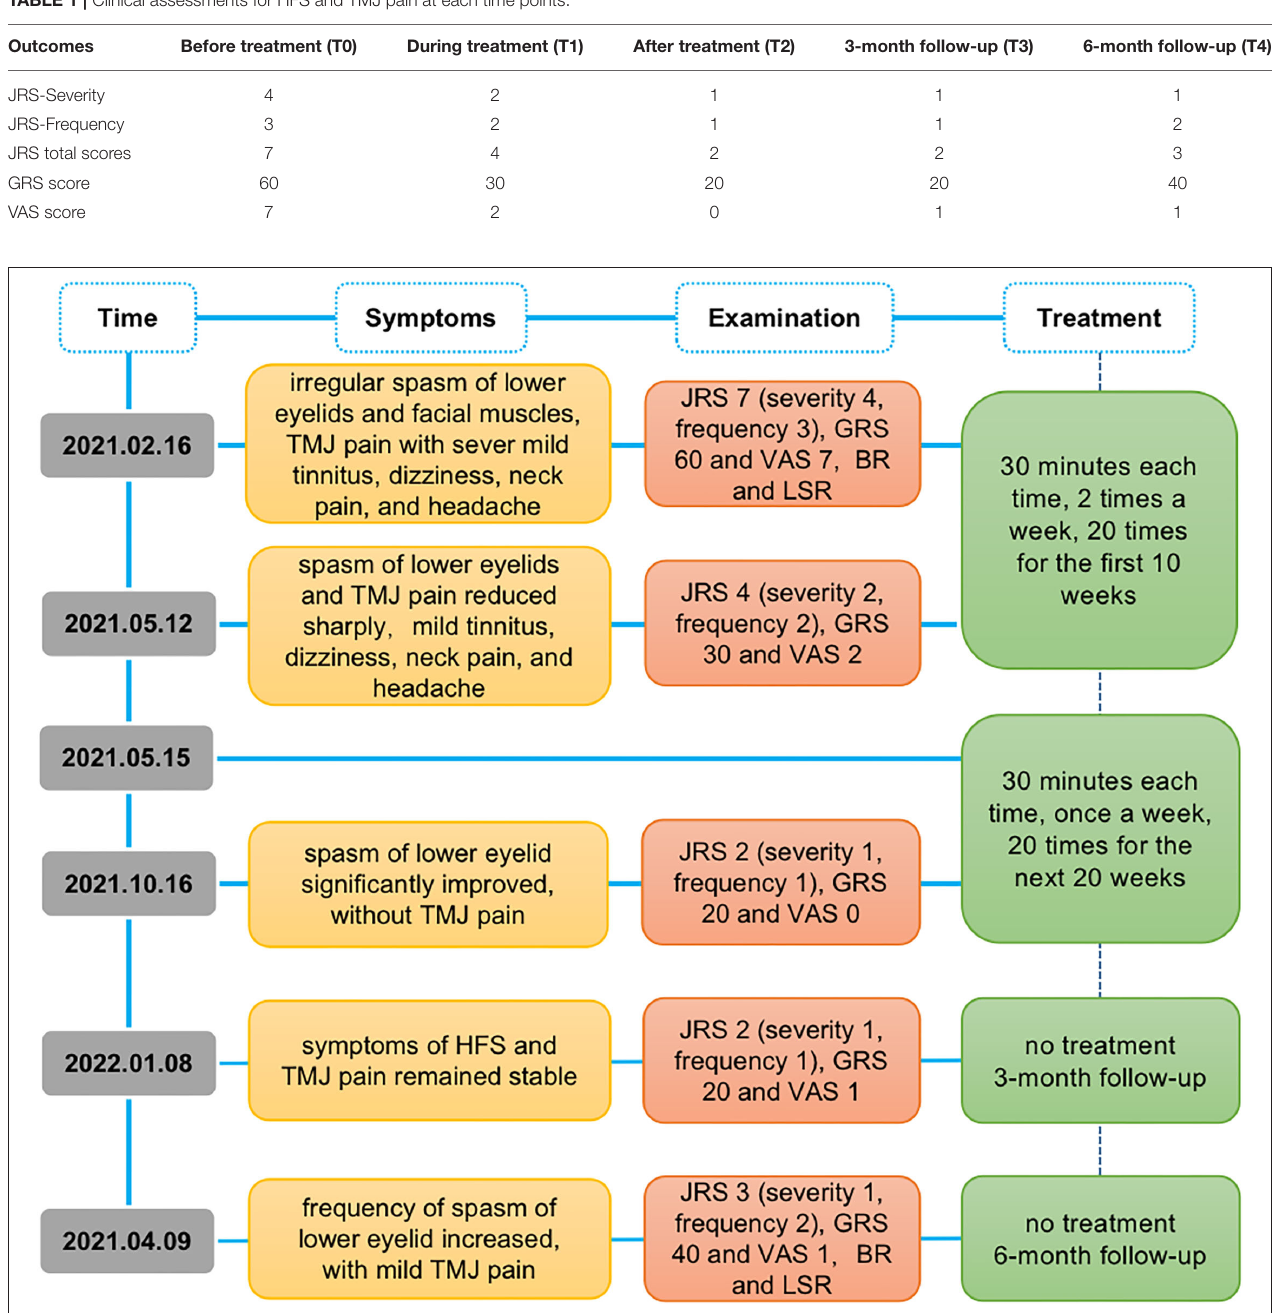
FIGURE 3 | Study timeline. JRS, Jankovic Rating Scale; GRS, global rating scale; VAS, visual analog scale; BR, blink reflex; LSR, lateral spread